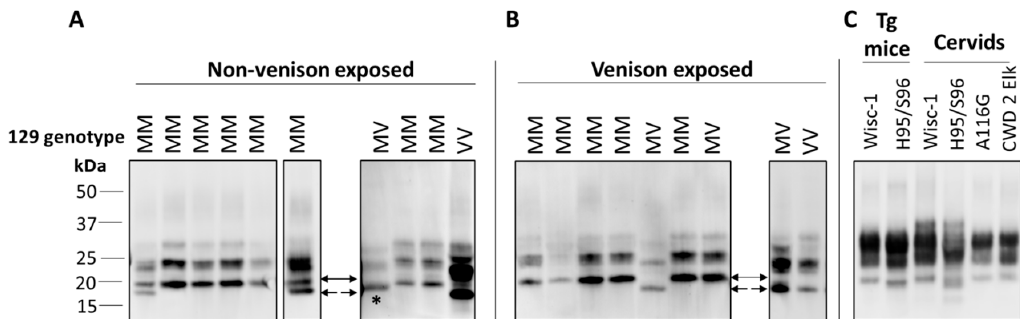
Figure 1. Immunoblot profiles of PK-resistant PrP from brains of Creutzfeldt–Jakob disease (CJD) patients, with or without exposure to venison, compared with chronic wasting disease (CWD) strains. ( A , B ) Typing studies for non-venison ( A ) and venison ( B ) exposed CJD cases were carried out as described previously [78], with 10% brain homogenates in lysis buffer (LB100) (100 mM Tris HCl pH 7.0, 100 mM NaCl, 10 mM EDTA, 0.5% Nonidet-P 40, 0.5% sodium deoxycholate) digested with 70 U/mL PK for 1 h at 37 °C. Different sample volumes were loaded or blots from different runs were included to obtain a similar PrP signal intensities for comparison of banding profiles. Type 1 (21 kDa) is indicated by a solid arrow, Type 2 (19 kDa) by dashed arrow, and 20 kDa from variably protease sensitive prionopathy (VPSPr) indicated with * . Primary Ab: 3F4. ( C ) Typing study of CWD strains, with 10% homogenates in LB100 pH 8.0 digested with 30 U/mL PK. Wisc-1 was propagated in Tg33 mice and H95/S96 was first passaged in Tg60 mice. BH from deer and elk harboring different polymorphisms was also analyzed. Primary Ab: Sha31